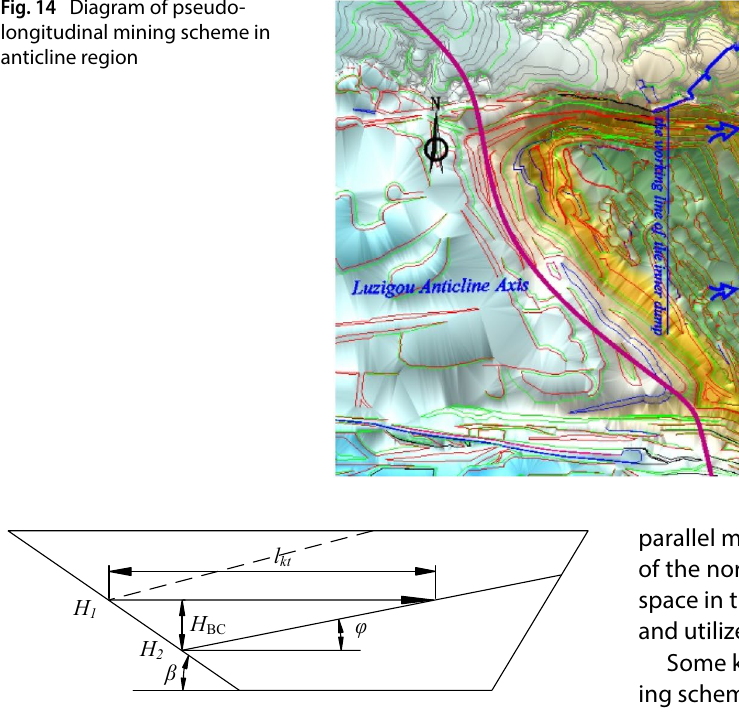
Fig. 15 Diagram of relationship between horizontal advancing speed and vertical deepening speed